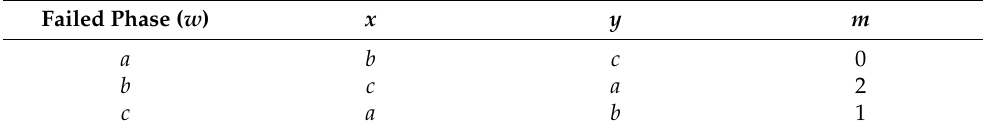
Table 2. Reconfiguration